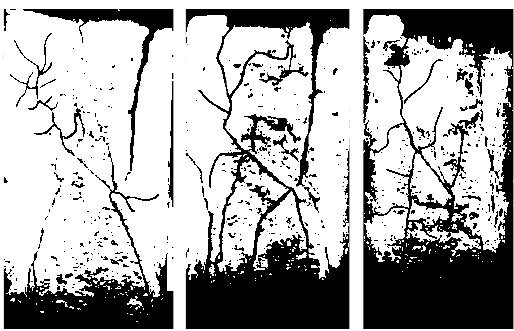
Figure 9. Binarization results of specimen fracture.